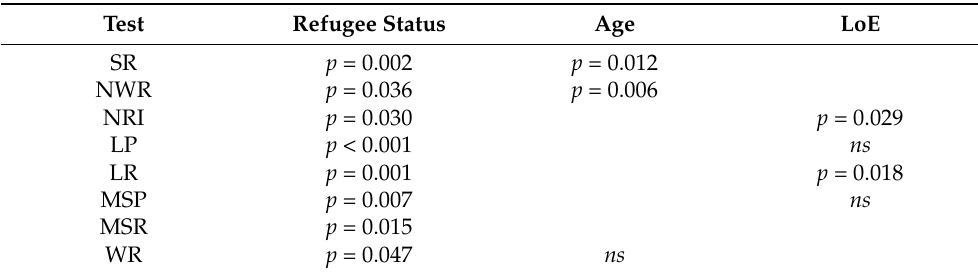
Figure 4. Distribution of bilingual refugee and non-refugee children’s scores to the LITMUS tasks: LITMUS-SR-French (SR), LITMUS-QU-NWR (NWR), no-risk index (NRI). Table 2. Summary of the predictors involved in best fit models assessing the role of refugee status and individual variables on language measures.